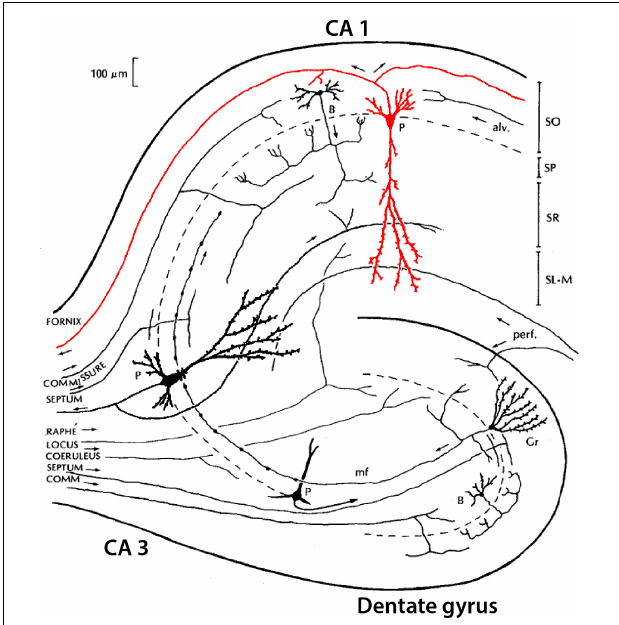
FIGURE 5 | Simplified summary of neurons in the hippocampus, showing the three main subregions: dentate gyrus (DG), CA3, and CA1, with their three main principal neurons: granule cell (Gr), and pyramidal (P) cells in CA3 and CA1. Examples of interneurons are shown for basket (B) cells in dentate gyrus and CA1 [Adapted from NeuronDB: (https://senselab.med.yale.edu/